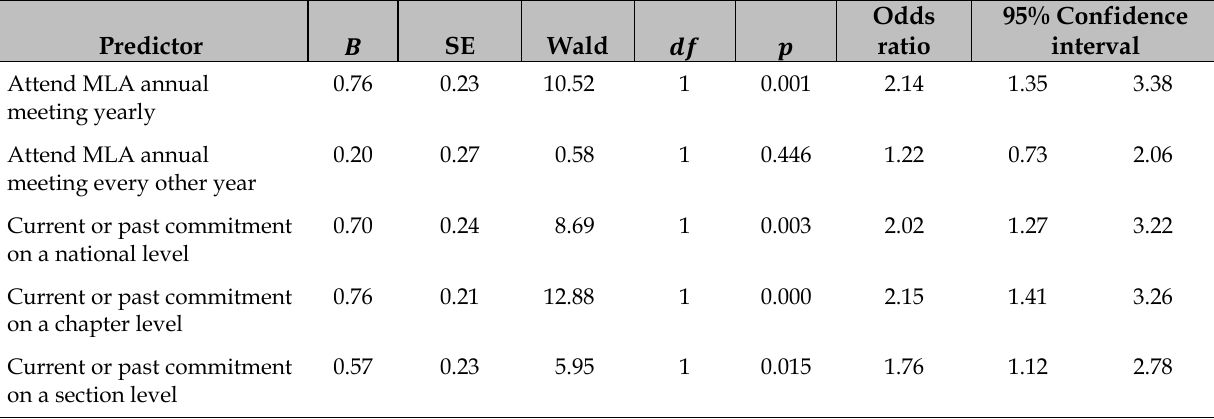
Table 3 Results of logistic regression predicting the likelihood of always voting